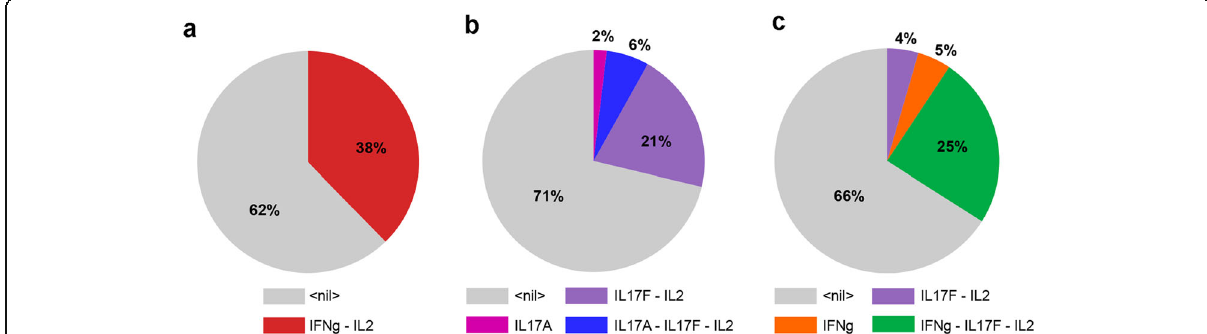
Fig. 5 Stochastic simulations of the wild type model. MaBoSS was used to simulate the evolution of cell populations for each of the considered environmental conditions, starting from naive Th0 state. The probabilities associated with each phenotype is computed from the number of stochastic simulations leading to each phenotype from pre-defined initial conditions. a Wild type simulation in the presence of pro-Th1 cytokines, which gives rise to IFN- γ + cells. b Wild type simulation in the presence of pro-Th17 cytokines, which gives rise predominantly to IL-17F+ + cells, a smaller proportion of double IL-17A + + IL-17F+ + , and a still smaller proportion of single IL-17A+ + cells. c Wild type simulation in the presence of IL-12 + IL-1 β , which give rise to cells expressing combination of IL-2, IFN- γ and/or IL-17F (but not IL-17A). In each case, the large grey sector correspond to cells remaining in a non activated state. Although the percentages obtained are sensitive to updating rates, these simulations point to key differences in the specific cell phenotypes obtained for different combinations of Th1/Th17 polarizing